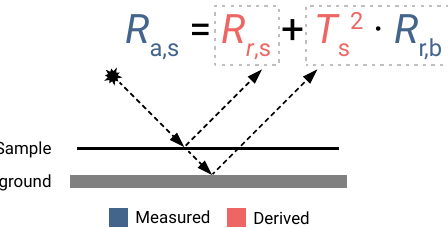
Figure A2. Ray path showing the occurrence of the sample’s apparent reflectance ( R a,s ) and its components, i.e., its real reflectance ( R r,s ), its transmittance ( T s ), and the real reflectance of the background ( R r,b ) after Miller et al. [62]. The distance between the sample and the background is enlarged for the purpose of